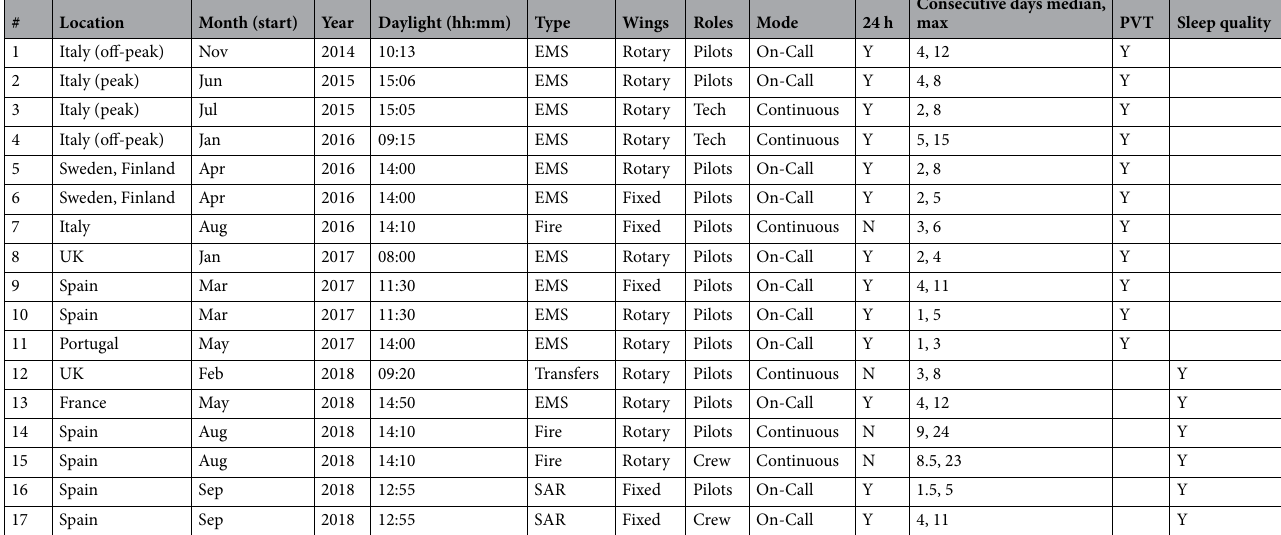
Table 1. Summary information for each of the datasets, presented in chronological order. Datasets are shown by geographic location (Location), start month (Month) and year (Year) of data collection, daylight hours at that location at that time of year (Daylight), Type of Operation (Type), whether the operation involved fixed or rotary (helicopter) wing aircraft (Wings), participant job roles (Roles), whether the operation involved continuous or “on-call” work (Mode), whether the operation ran across the full 24 h (24 h), the median and maximum number of consecutive days of duty in each dataset (Consecutive Days), whether PVT was